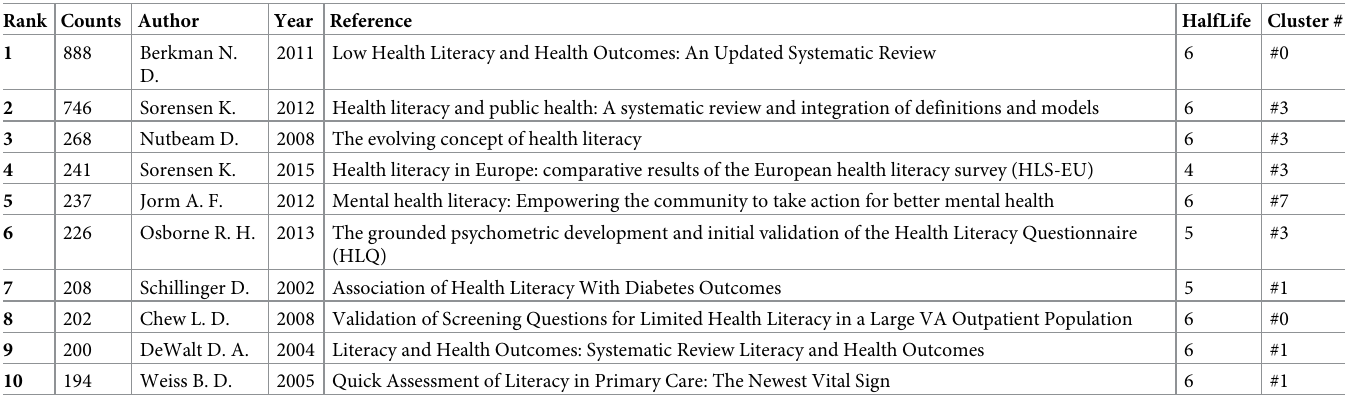
Table 4. Top 10 reference with the most co-citation of health